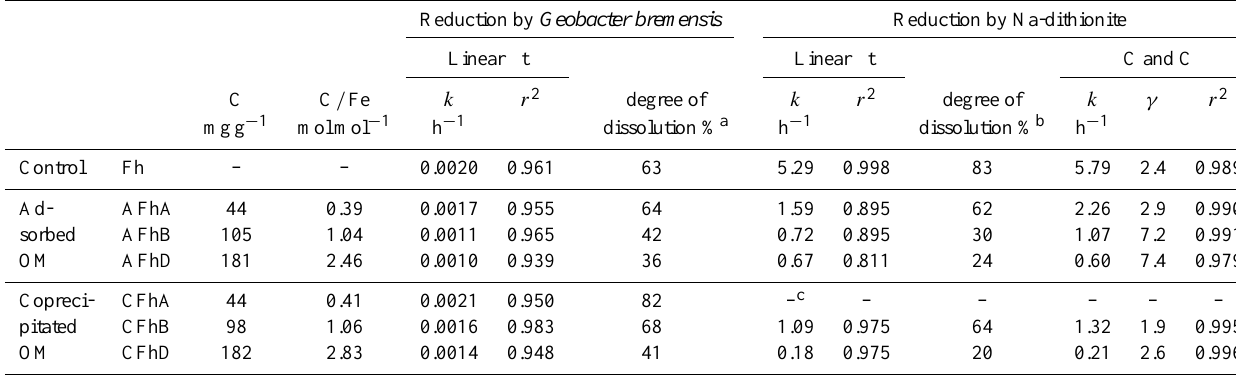
Table 1. Carbon concentration and C / Fe ratios of ferrihydrite-organic matter associations and results of microbial and abiotic reduction experiments. See text for